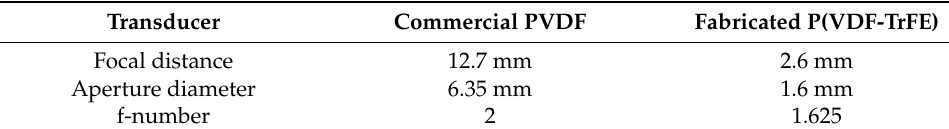
Table 1. In-house fabricated P(VDF-TrFE) copolymer and commercial PVDF transducers’ specifica- tion.